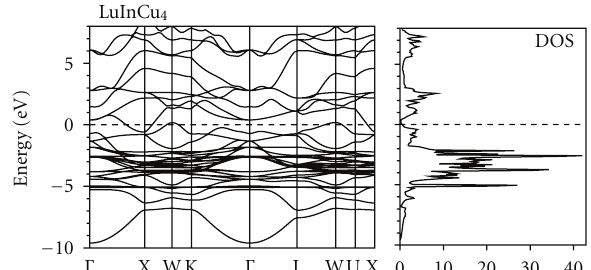
Figure 92: LSDA self-consistent fully relativistic, spin-polarized energy band structure and total DOS (in states/(unit cell eV)) of LuInCu 4 [475].